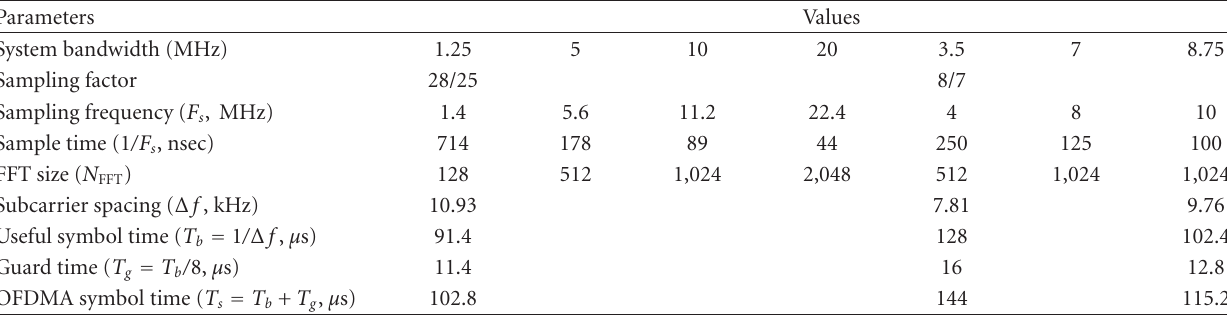
Table 1: OFDMA parameters for Mobile WiMAX [3, 8, 9].